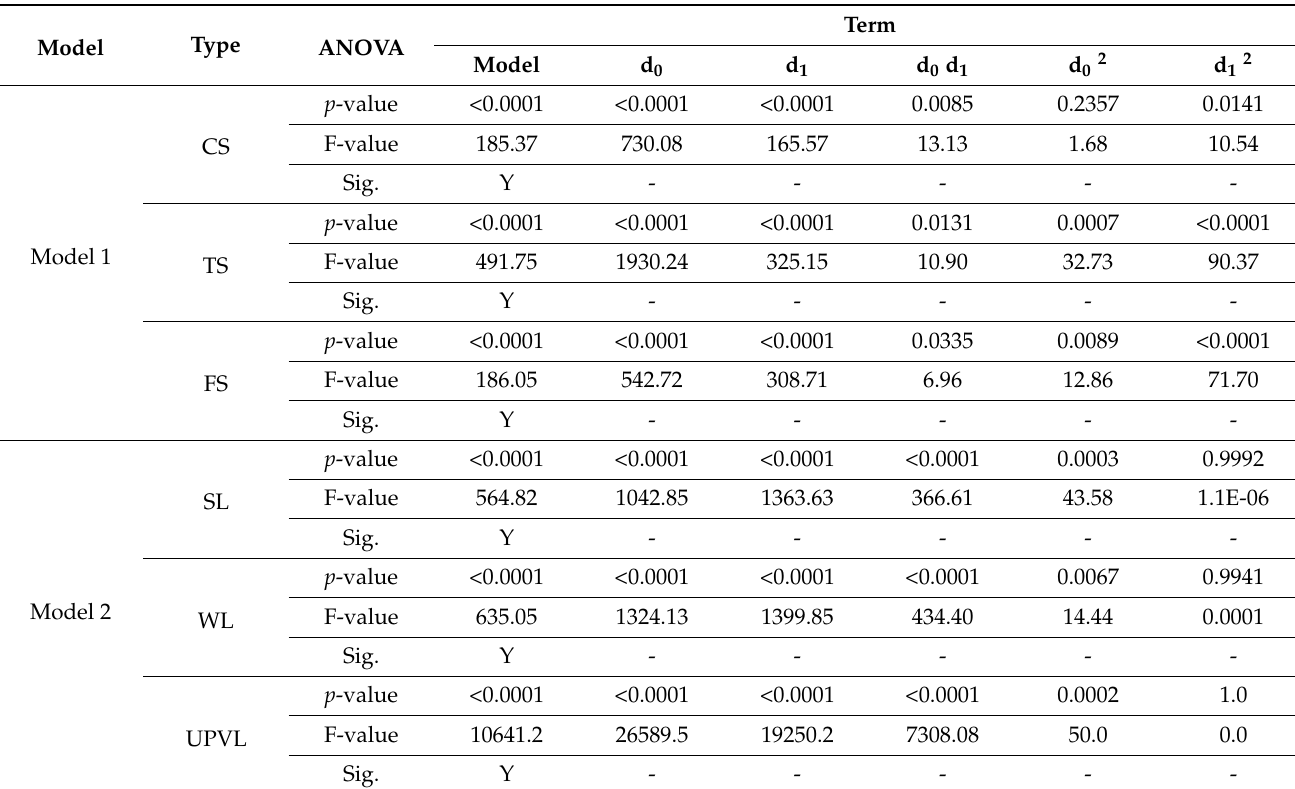
Table 3. Validation of the proposed models using